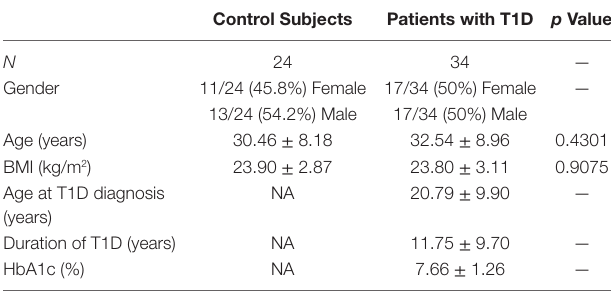
Table 1 | Data from the control subjects and patients with T1D recruited for the study.